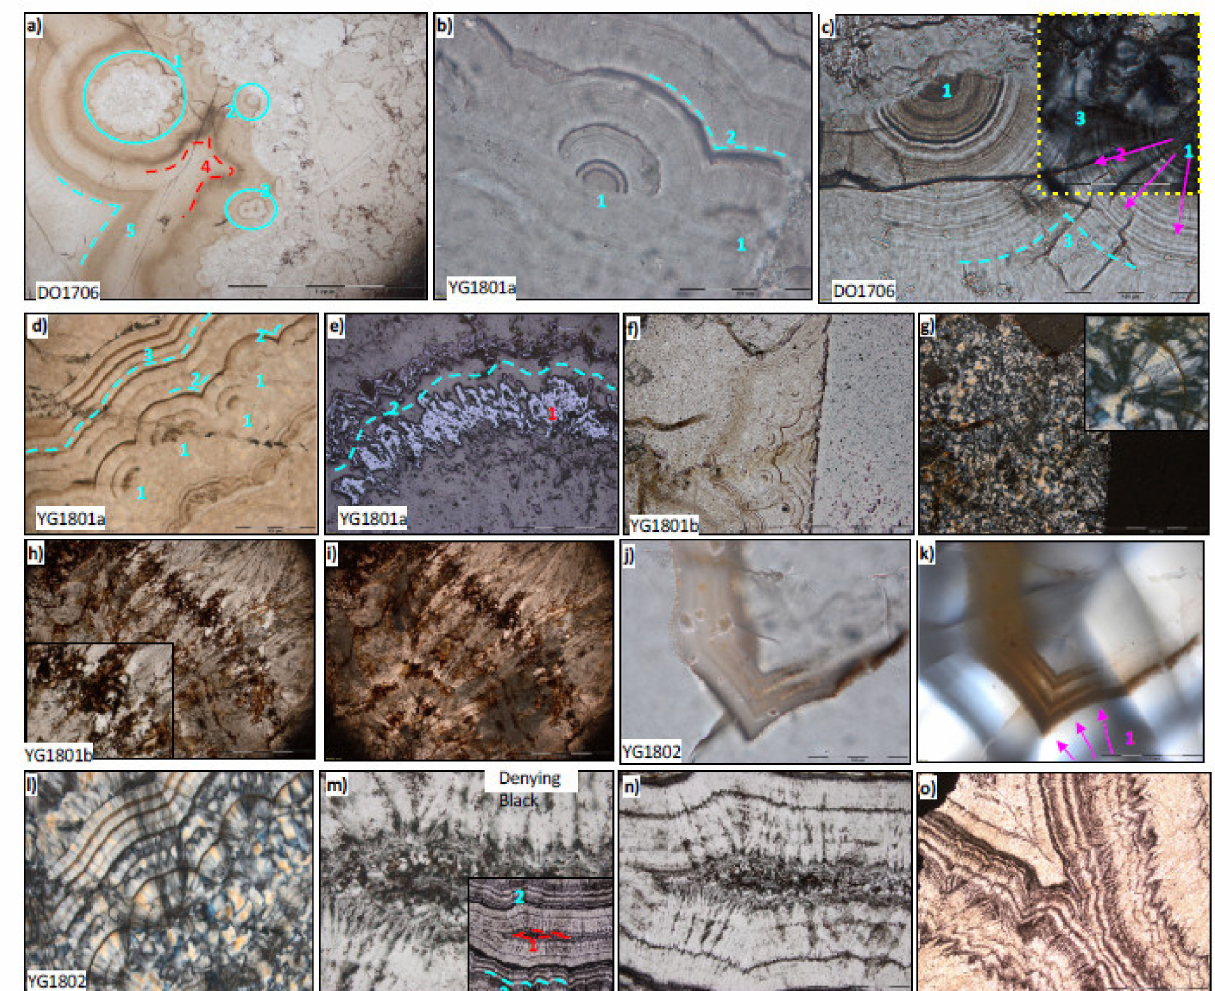
Figure 6. Microscopy images of the studied samples. ( a ) plane polarised light image of a section of D01706 showing features of spherical botryoids as clusters onto a large central botryoid (1), lone circular botryoids (2), pairs of botryoids growing close together (3), cavity structure (4), and open book structure with intersected circularly concentric laminations (5). ( b ) plane polarised image of a section of YG1801a showing features of part botryoids (1) and open book banding intersection (2). ( c ) Plane polarised light image of a section of DO1706 where the inside yellow dotted square is the cross-polarised light image of the same section of rock superimposed onto the main image. There are features of part botryoids (1) in both plane and cross polarised light with the magenta arrows (2) that indicate the radial crystal growth pattern direction. Note that in cross-polarised light there is a clear line of the intersection (3) between the two botryoidal growths where the form an open-book structure. ( d ) Plane polarised light image of YG1801a showing botryoids (1) associated with curved laminations formed of intersected circularly concentric laminations. ( e ) Reflected light image of YG1801a that show a sub-circular layer of sub-radially aligned blade of Fe-oxides (1) with equidistant laminations, and ( f – g ) Botryoids of fine grained quartz with circularly concentric laminations of organic matter and radially aligned acicular quartz, best seen under cross polars in ( g ) and in its inset, where darkened ‘iron cross’ domains flare outward and at about 90o from each other, a tell-tale sign of sphericity. ( h , i ) Plane and cross polarised light images of sub-radially aligned blades of carbonate stained with filamentous black-opaque organic matter (zoom shown in inset for YG1801b), which forms a chaotic band lining the cavity structure. ( j , k ) open-book structure in coarse quartz and ( l ) botryoids in fine quartz from YG1802. ( m – o ) Plane polarised light images from the Dengying carbonate specimen that show an elongated cavity (1) formed from sub-parallel bands (2) in the fabric of radial, bladed carbonate crystals (note high order interference colours in inset of m), which are coated with black organic matter concentrated specifically along grain boundaries and inside the cavity structure ( m – n ). As seen in the quartz specimens from the Doushantuo Fm, laminations are contrasted by the variable concentrations of disseminated organic matter, which yield colour gradients in laminations (seen in